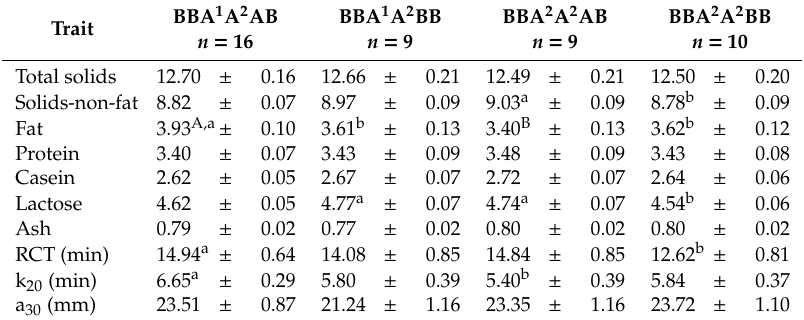
Table 4. Chemical composition (g / 100 g) and MCP of Agerolese cattle milk according to the composite